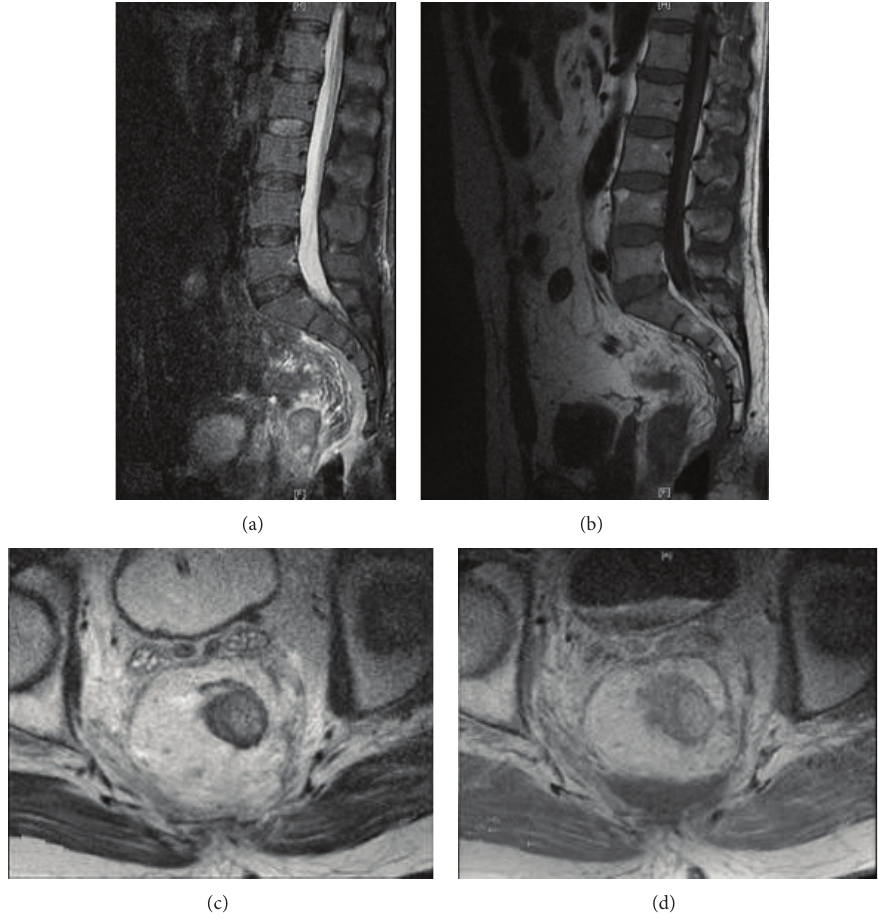
Figure 2: Sagittal and axial MRI following the removal of the mass.